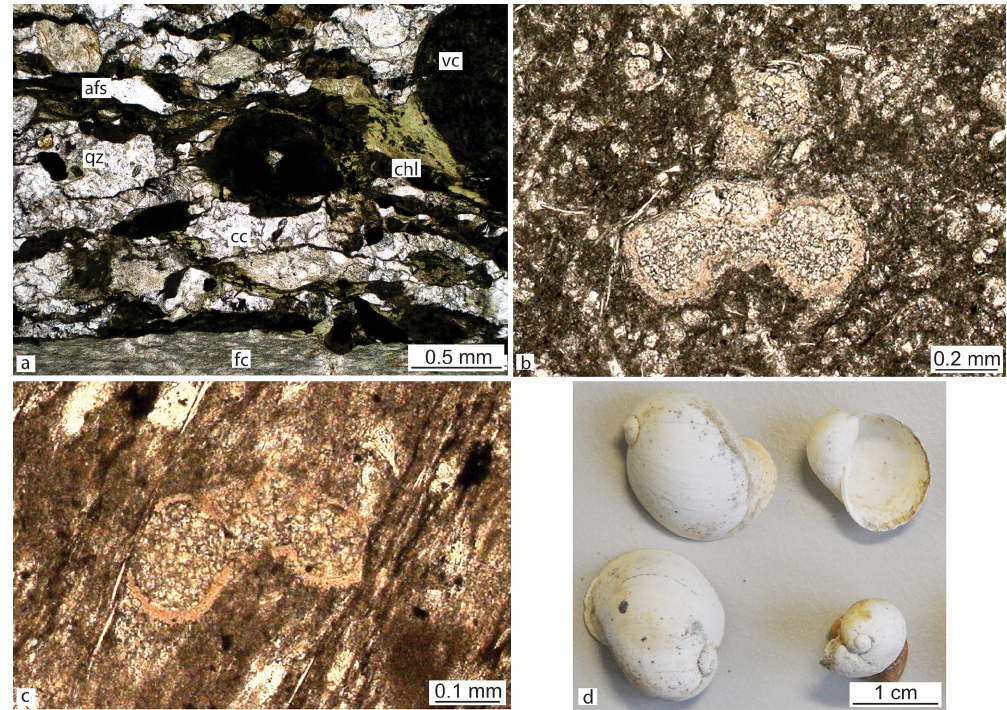
Figure 7. Photomicrographs of thin sections: (a) metamorphic conglomerate, sample 10-029, with metamorphic chlorite (chl) in a calcitic matrix. Other clasts: fc is felsic clast, afs is feldspar, qz is quartz and vc is volcanic clast; (b) Turonian Helvetoglobotruncana helvetica (93.5 and 90Ma) in marls on the transgressive discordance; (c) Late Cretaceous ( > 66Ma) Globotruncana sp. in the marls intercalated with sample 10-128; (d) Pliocene to recent art Radix Auriculata found in the lacustrine sediments.